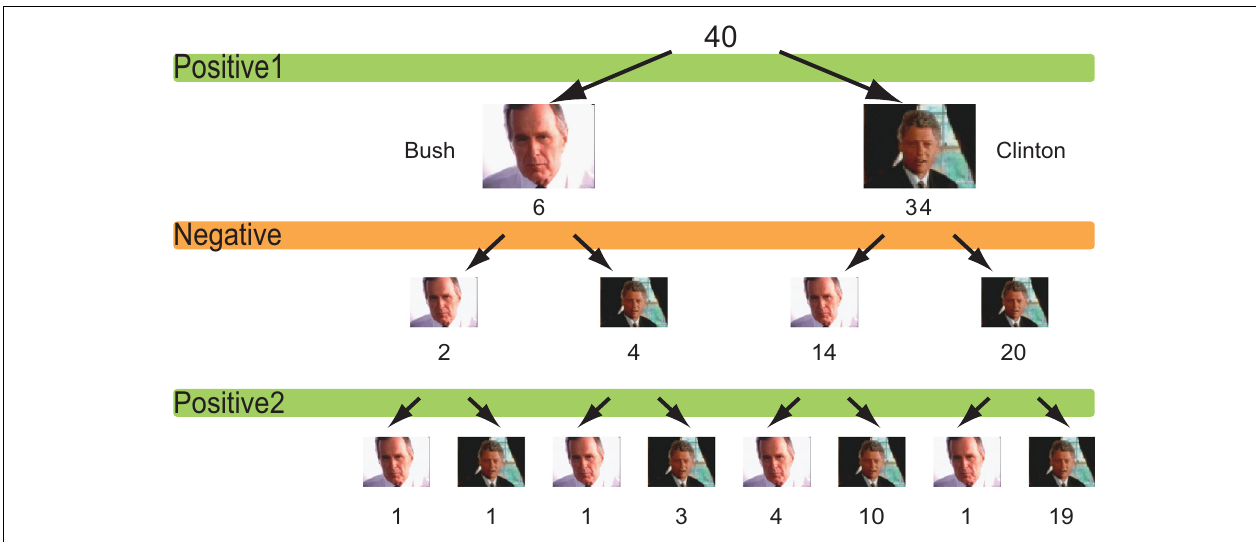
FIGURE 2 | Choice of candidates. The number of participants who chose either Bush or Clinton after each campaign advertisement session.